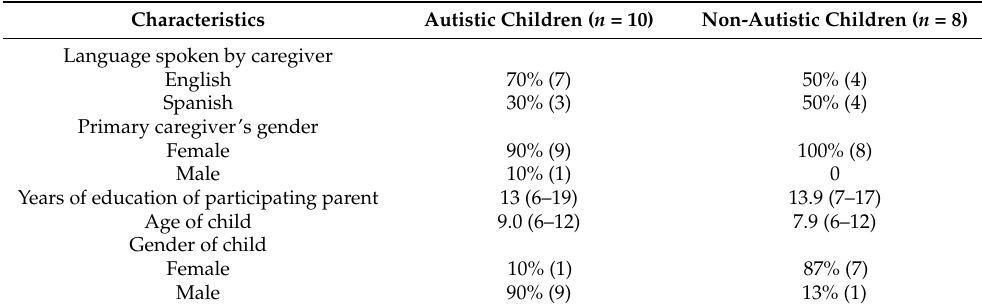
Table 1. Demographic information of